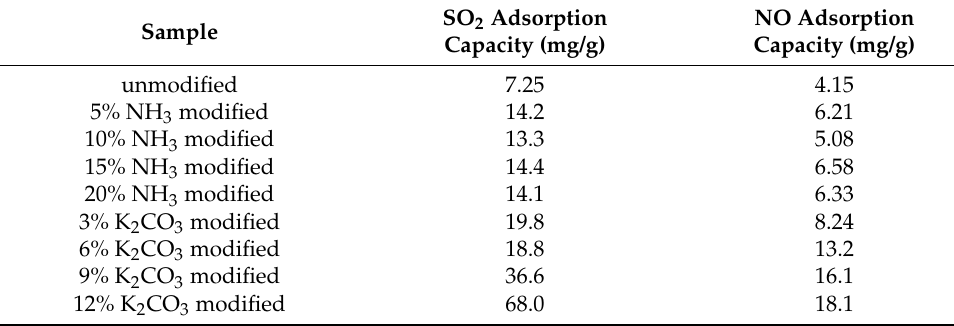
Table 2. SO 2 /NO adsorption capacity per unit mass of activated coke.